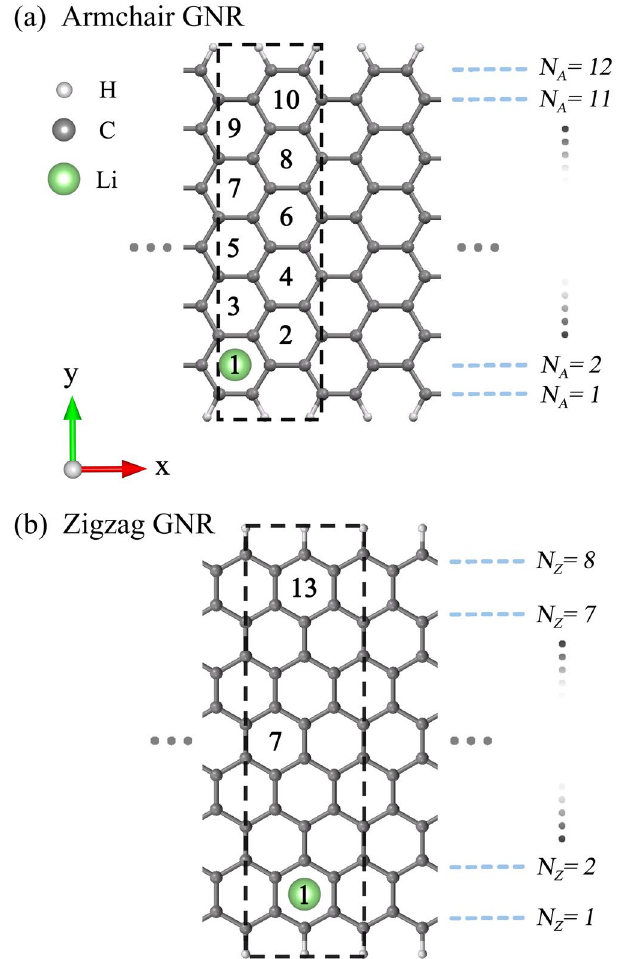
Figure 1. Geometric structures of alkali-adsorbed GNRs for ( a ) N A = 12 armchair and ( b ) N Z = 8 zigzag systems. The dashed rectangles represent unit cells used in the calculations. The lattice constants are, respectively, a = 3 b and = a b 2 3 for armchair and zigzag GNRs. Numbers inside hexagons denote the adatom adsorption positions.